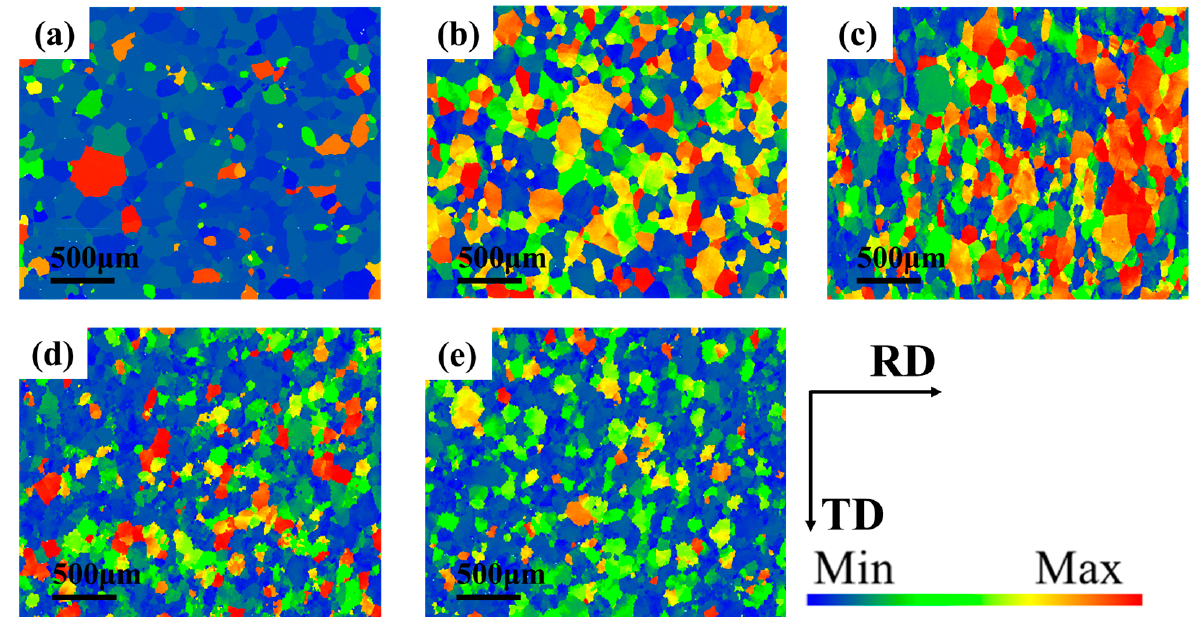
Figure 17. Taylor Factor distribution at different temperatures: ( a ) original; ( b ) 400 °C; ( c ) 425 °C; ( d ) 450 °C; ( e ) 475 °C.